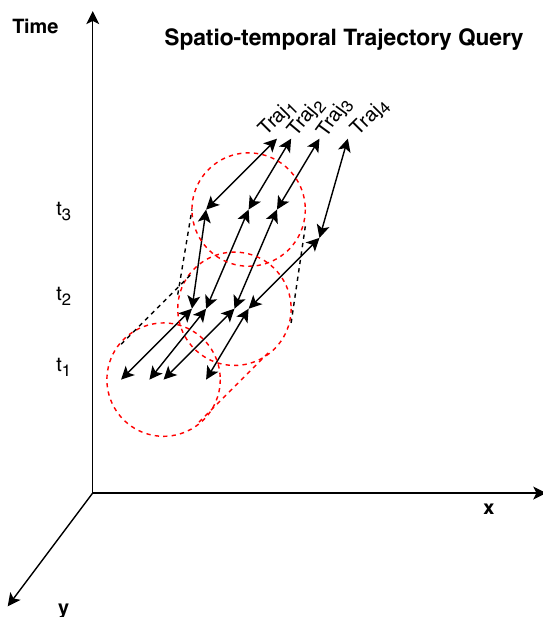
Figure 1. An Overview of Continuous Trajectory Point k Nearest Neighbor ( CTPkNN )